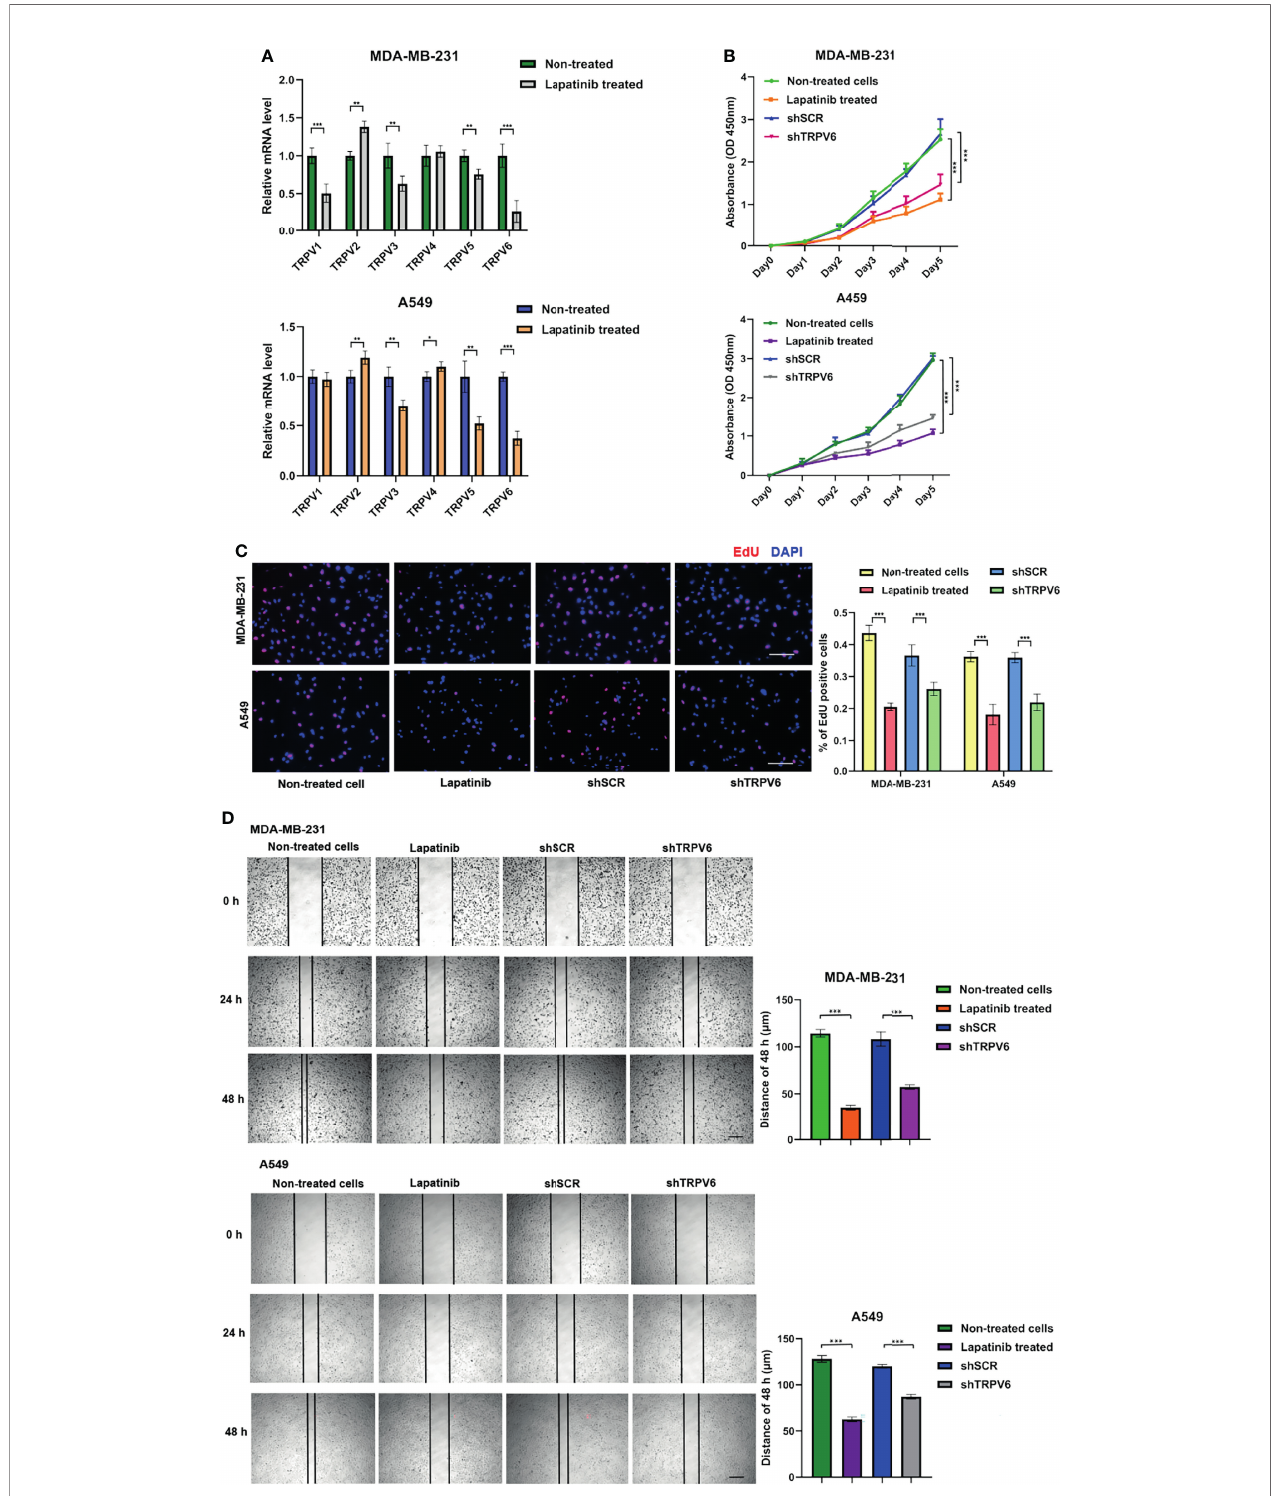
FIGURE 8 | Effects of lapatinib and TRPV6 knockdown on cell proliferation and apoptosis in cancer cells. (A) TRPV channels mRNA expression in MDA-MB-231 and A549 cell lines after treatment with lapatinib. (B) The effect of TRPV6 knockdown and exposure to lapatinib on cell proliferation in MDA-MB-231 and A549 cell lines examined by the CCK8 assay and the (C) EdU assay. (D) The scratch assay was performed in MDA-MB-231 and A549 cells treated with shTRPV6 or 8 m M lapatinib. Values were expressed as mean ± SD from three independent experiments (Student ’ s t test, * P < 0.05, ** P < 0.01, *** P < 0.001). Scale bars, 50 m